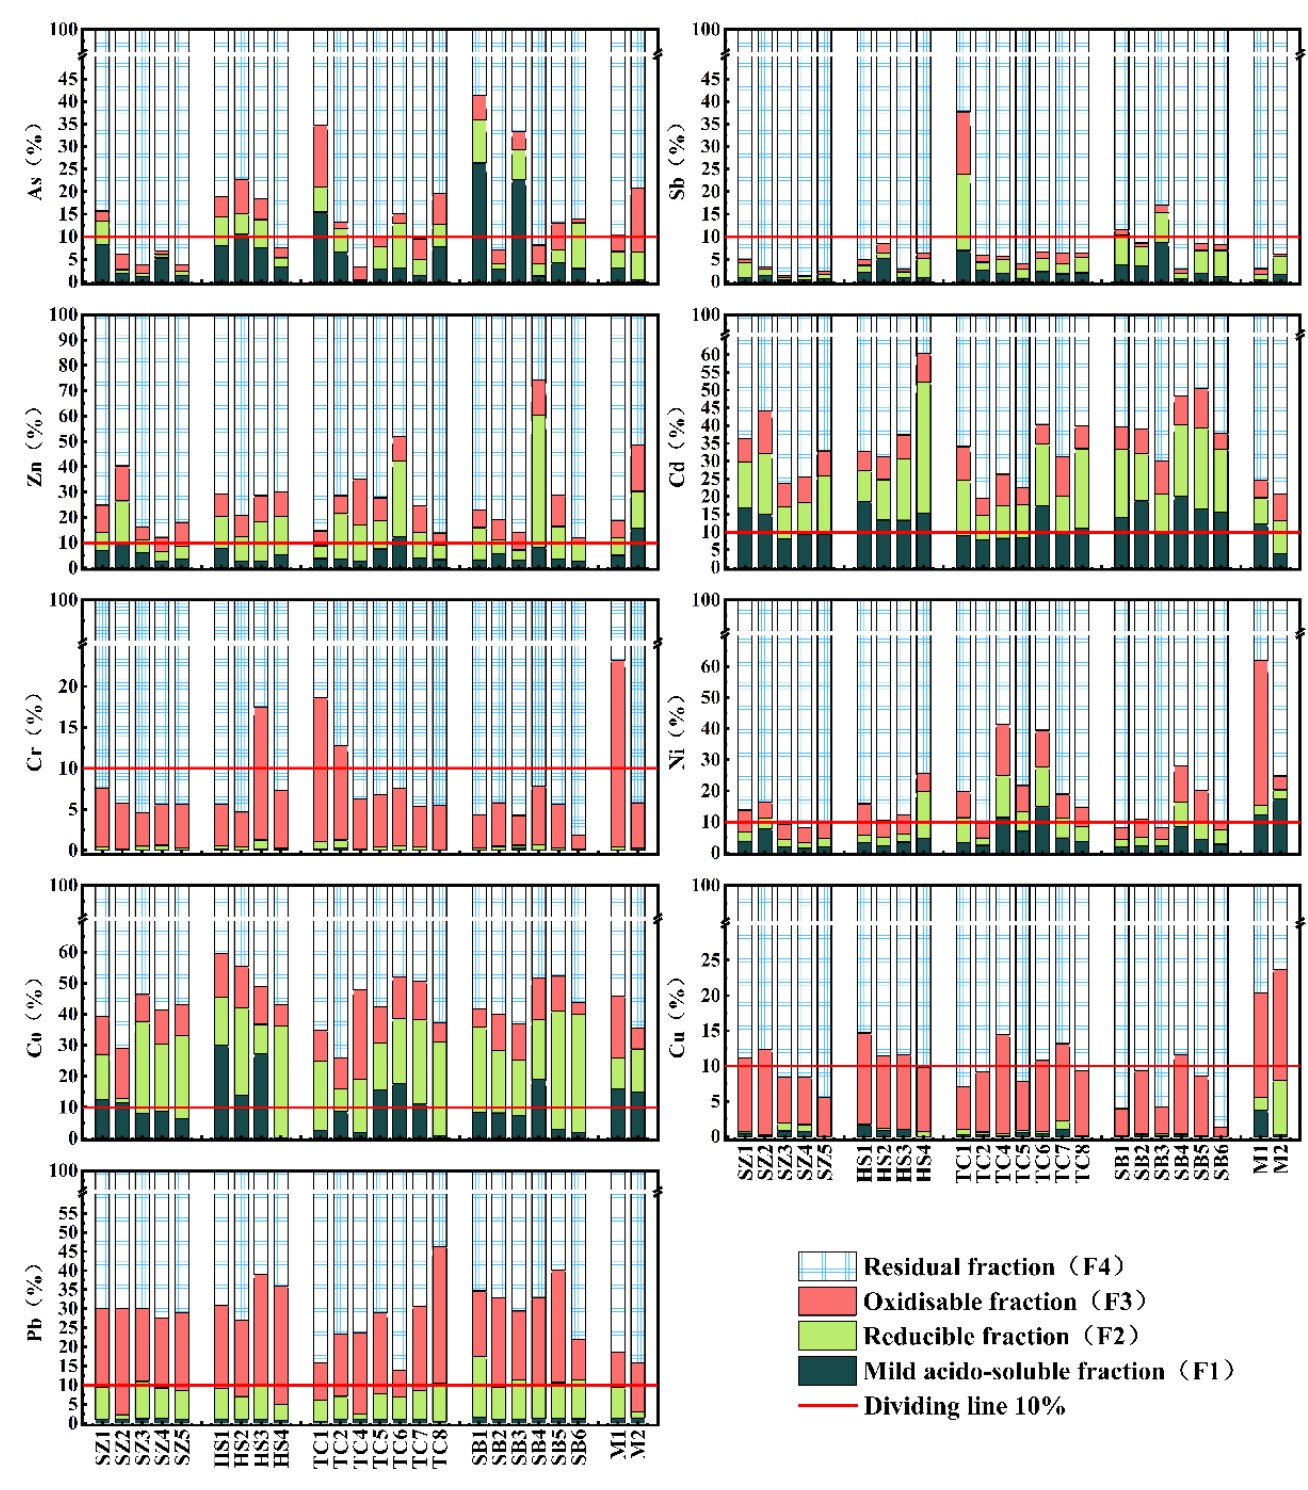
Figure 3. Percentage of four chemical fractions of As and HMs in sediments based on the BCR method.